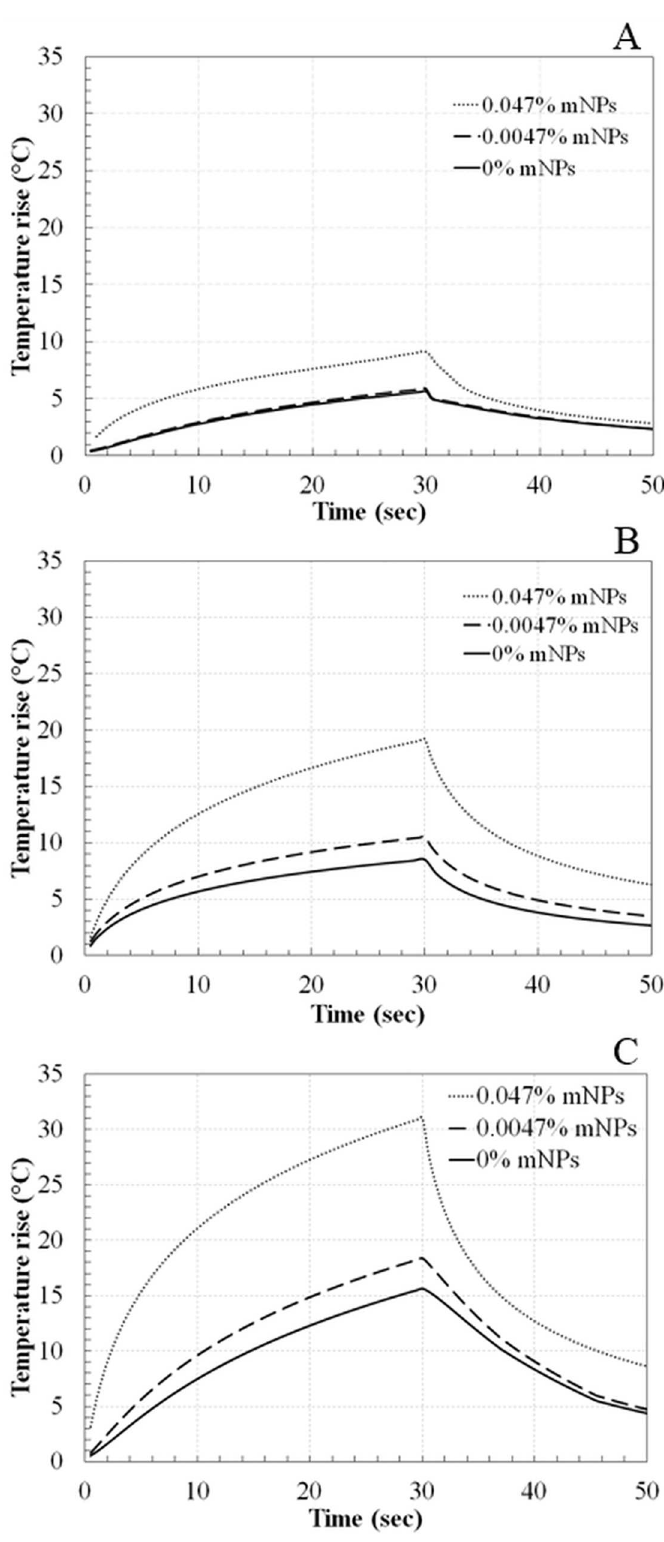
Fig 8. Temperature variationwith time at focus in tissue phantomswith 0%, 0.0047%, and 0.047%mNPs concentrations using acoustic power of (A) 5.2 W, (B) 9.2 W, and (C) 14.5 W for a sonicationof 30 sec.